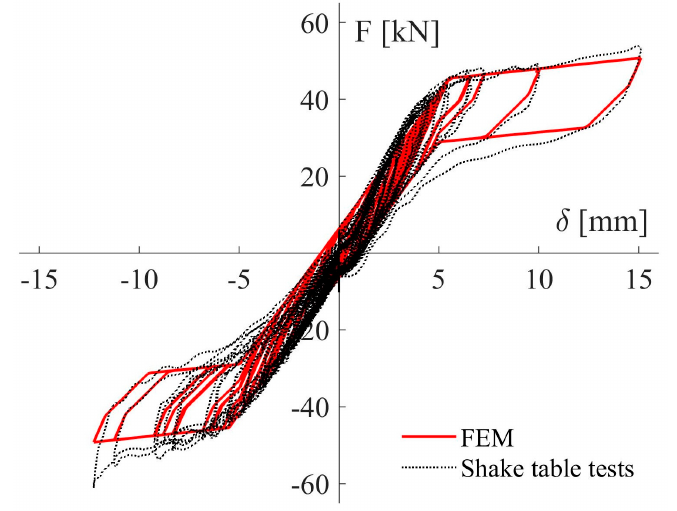
Figure 20. Experimental test vs numerical models implemented in FEM software.